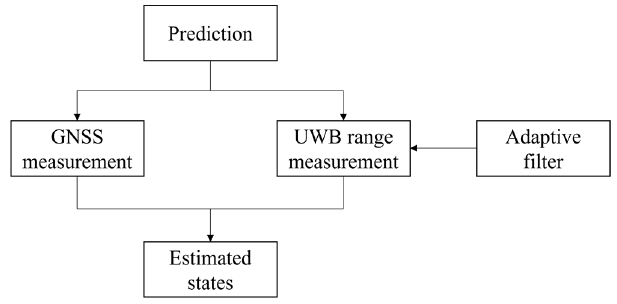
Figure 4. Block diagram of DCLAEKF algorithm.